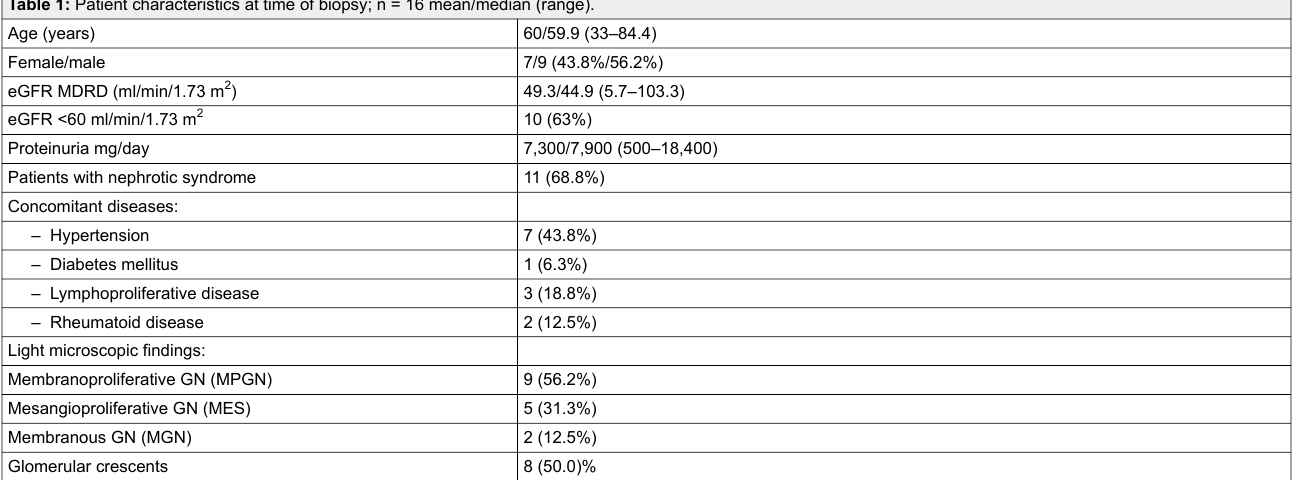
Table 1: Patient characteristics at time of biopsy; n = 16 mean/median (range). Age